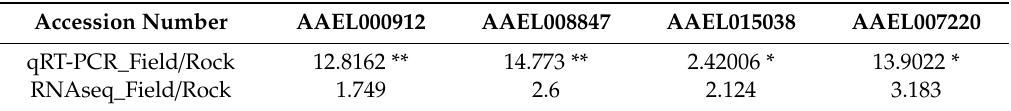
Table 7. Validation of expression of transcripts in field population compared to a lab population,